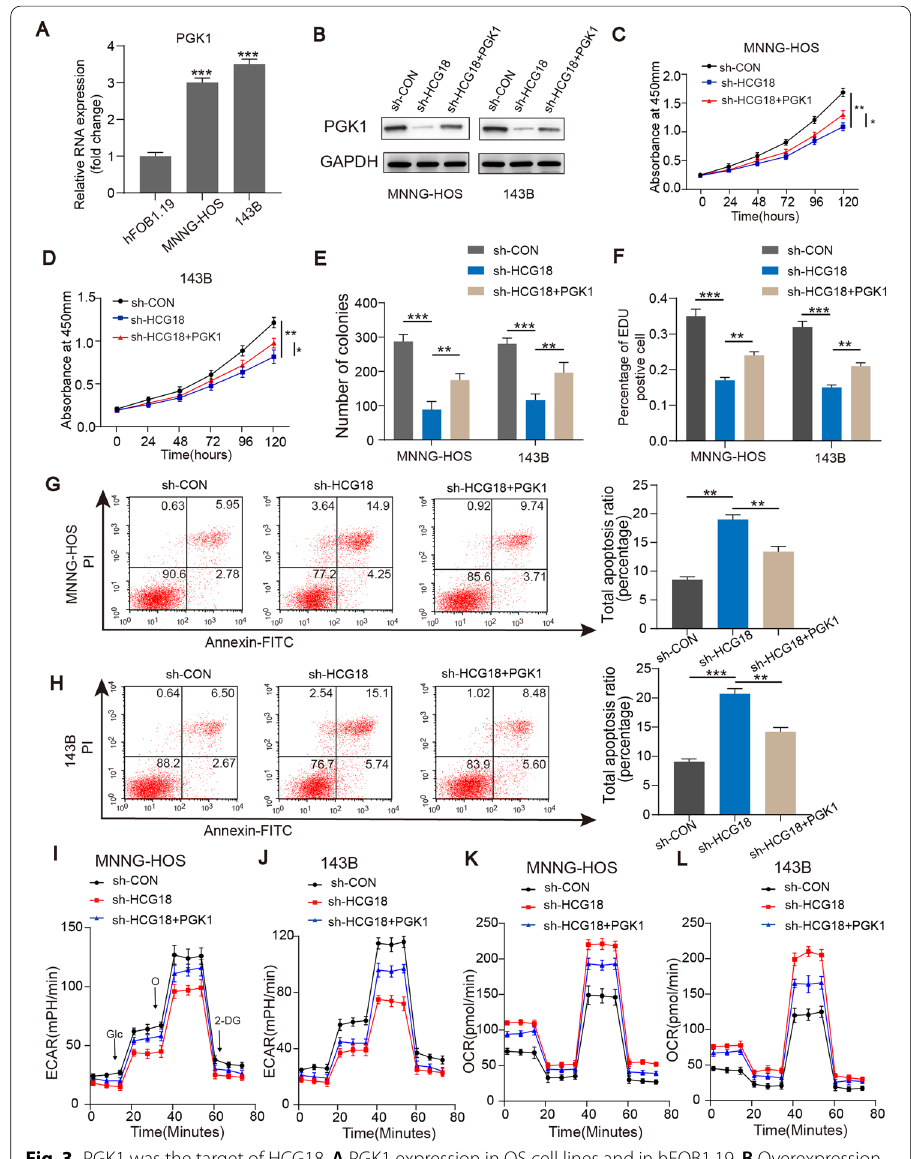
Fig. 3 PGK1 was the target of HCG18. A PGK1 expression in OS cell lines and in hFOB1.19. B Overexpression efficacy of PGK1 in sh-HCG18 OS cells. CCK8 ( C and D ), colony formation ( E ), EDU ( F ), and apoptosis ( G and H ) assays confirmed that overexpression of PGK1 partly reversed the suppressive effects of HCG18 knockdown on OS growth. I‑L , ECR and OCR in OS cells in different groups (sh-Control, sh-HCG18, and sh-HCG18 ov-PGK1) were measured. * represents P < 0.05, ** represents P < 0.01, *** represents P < 0.001. All + experiments were repeated three